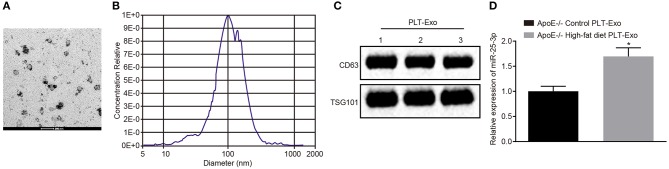
MiR-25-3p displays upregulated expression in peripheral blood PLT-Exo of atherosclerosis models of ApoE−/− mice. (A) Exosome structures identified by TEM. (B) Exosome diameter measured by NanoSight analyzer. (C) Protein bands of TSG101 and CD63, as determined by Western blot analysis. (D) MiR-25-3p expression in PLT-Exo, as determined by RT-qPCR. *p < 0.05 vs. the ApoE−/− control PLT-Exo group (PLT-Exo from control ApoE−/− mice). All data are measurement data and expressed as mean ± standard deviation, and data between two groups were analyzed using independent sample t-test. n = 7. The experiment was repeated three times independently.